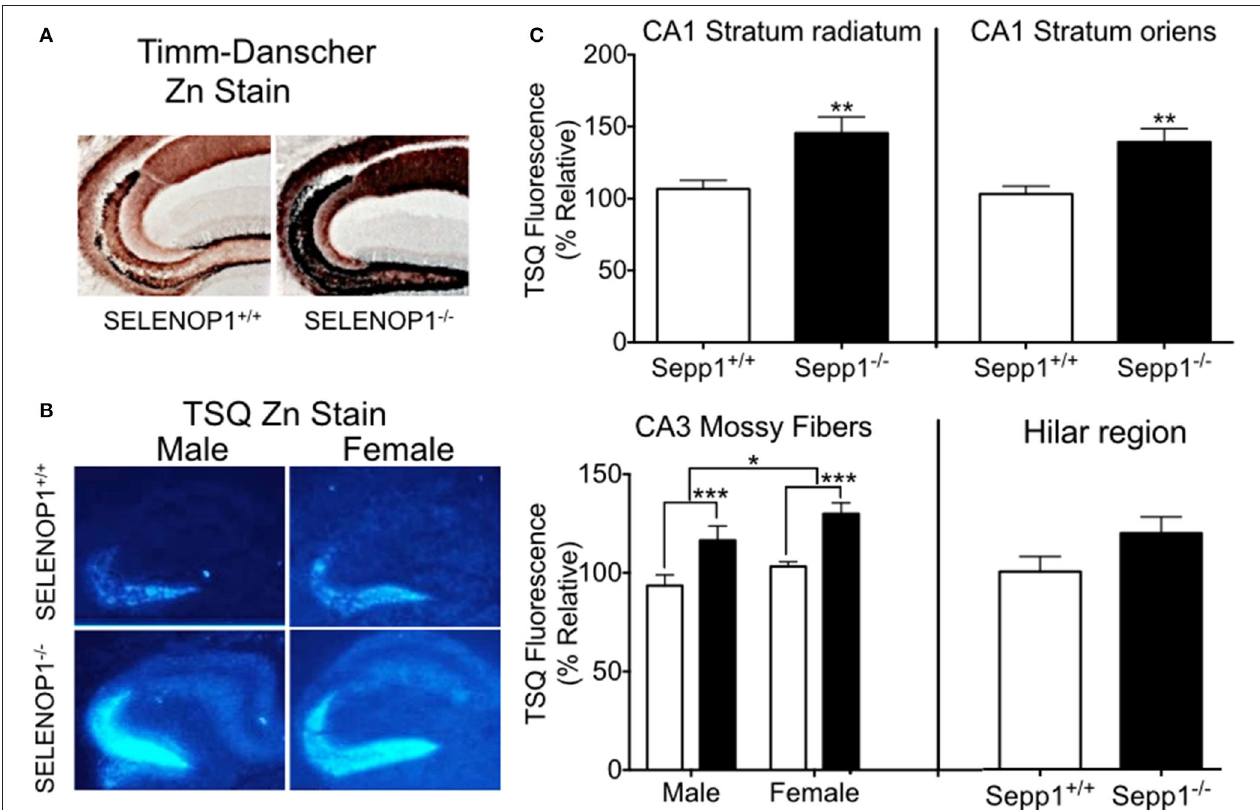
FIGURE 2 | Increased hippocampal zinc in SELENOP1 KO mice. (A) Neo-Timm’s (Danscher) stain. Free Zn 2 + in wildtype and SELENOP1 − / − hippocampal neurons from mice injected with sodium selenite is revealed as a reddish-brown to dark brown color relative to the amount of total Zn 2 + . (B) Representative images from male and female WT and SELENOP1 − / − mouse hippocampus, labeled with the fluorescent Zn 2 + indicator, TSQ. (C) Quantitation of TSQ fluorescent label indicates higher Zn 2 + levels in SELENOP1 − / − animals in all observed regions except for hilar region. The average values for each region were normalized to wild type males. N = 6 animals/group, 5–10 slices/animal. Statistical analysis is performed by Student’s unpaired t- test or two-way ANOVA with Bonferroni’s post-hoc test. * p < 0.05, ** p < 0.01, *** p <